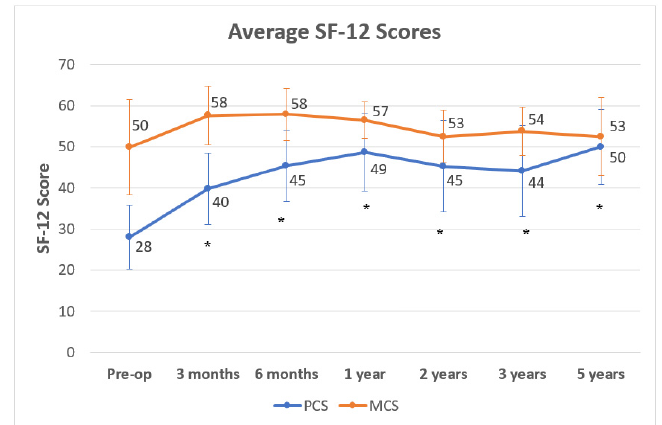
Figure 6. Average Short Form (SF)-12 scores from the pre-operative time point up to the 5-year post-operative time point for patients enrolled in the study, including physical (PCS, blue) and mental (MCS, orange) subscores. The graph reports averages +/ − SD. Asterisks (*) indicate statistical significance in comparison with the pre-op control, as determined by Student’s t -test ( p < 0.05). All knees treated were routinely evaluated radiographically pre- and postoperatively and showed and ideal implant fit without any over- or underhang of the